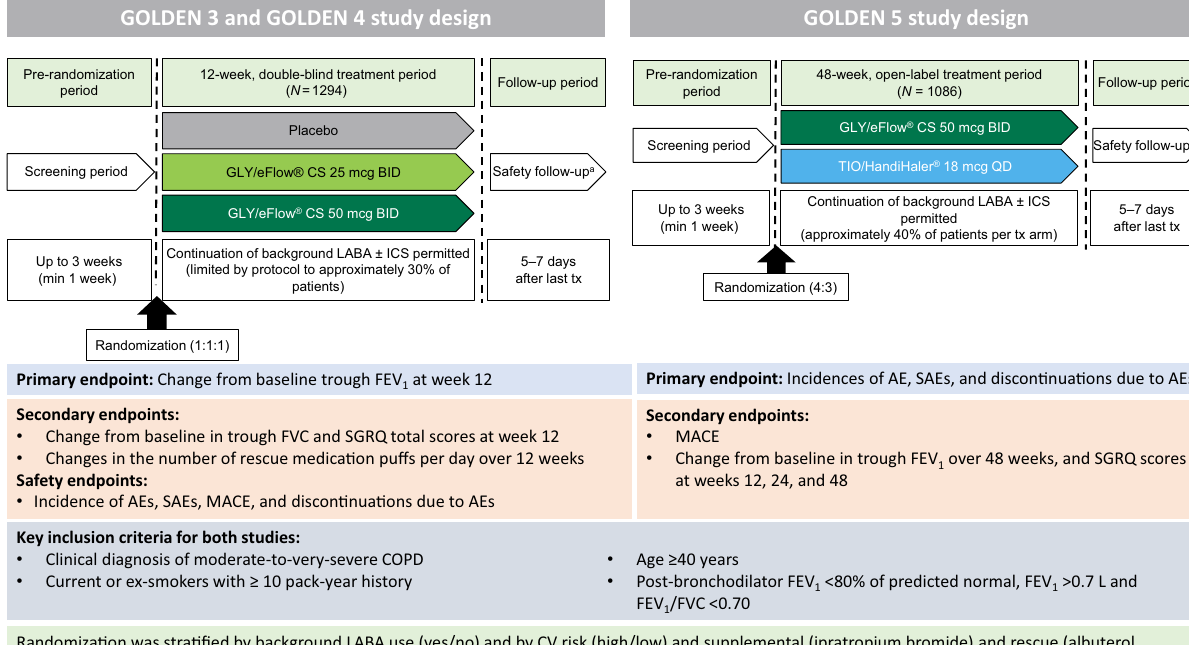
Fig. 1 GOLDEN 3, GOLDEN 4, and GOLDEN 5 study designs. a SAEs were monitored for 30 days after the last dose of study treatment. AE adverse event, BID twice daily, CS closed system, CV cardiovascular, FEV 1 forced expiratory volume in 1 s, FVC forced vital capacity, GLY nebulized glycopyrrolate, ICS inhaled corticosteroids, LABA long-acting β 2 -agonist, MACE major adverse cardiac event, min minimum, QD once daily, TIO tiotropium, SAE serious AE, tx treatment, SGRQ St. George ’ s Respiratory